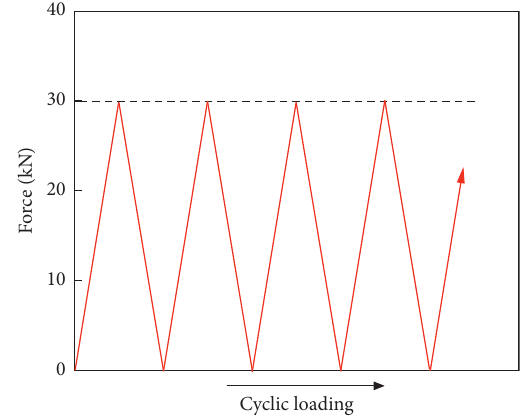
Figure 3: Cyclic loading path.